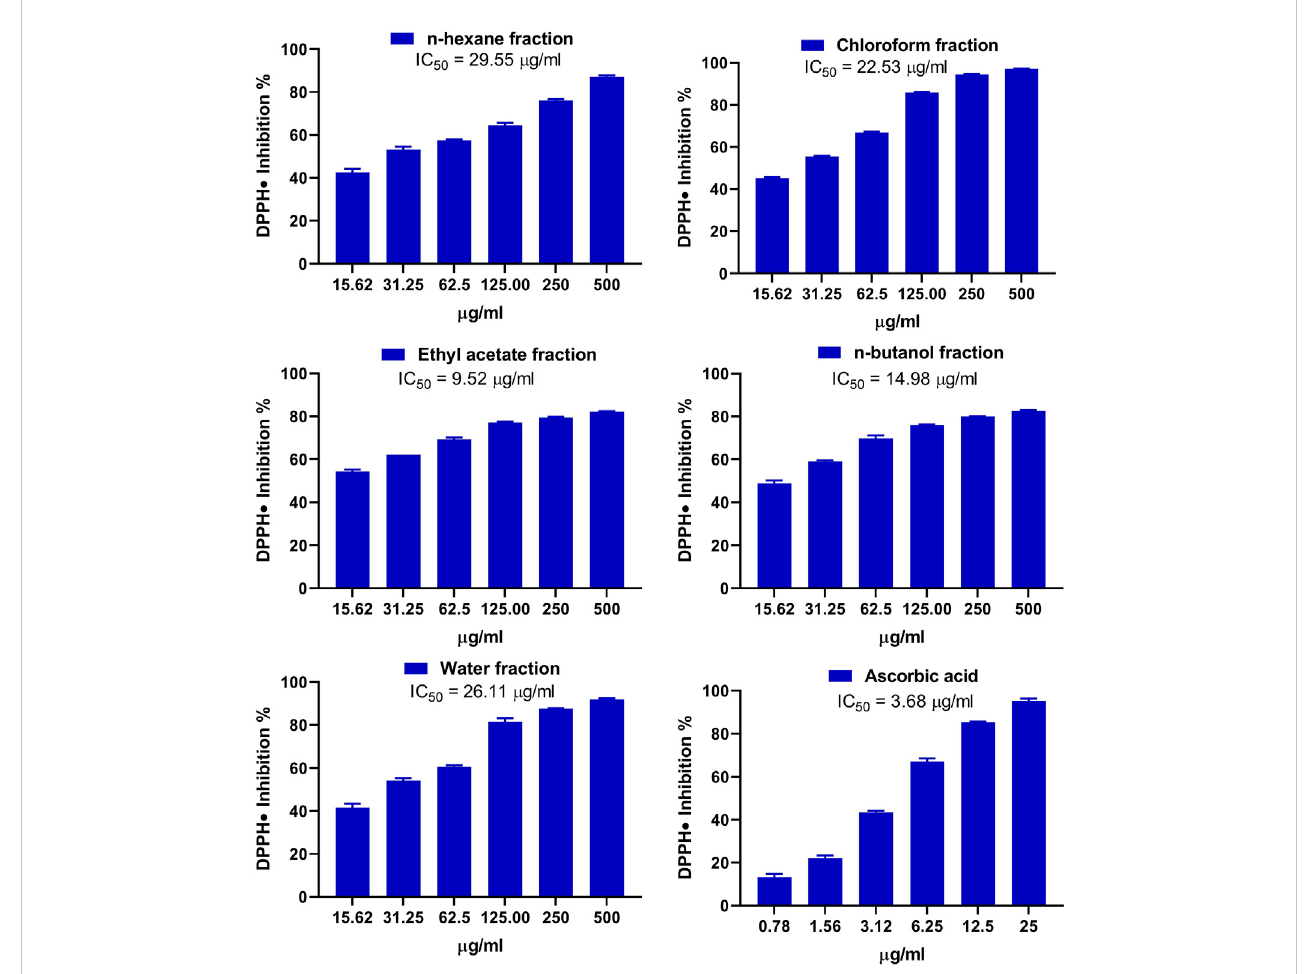
FIGURE 4 DPPH radical scavenging activity of the fractions of MEACL. Data are Mean ± SEM ( n =